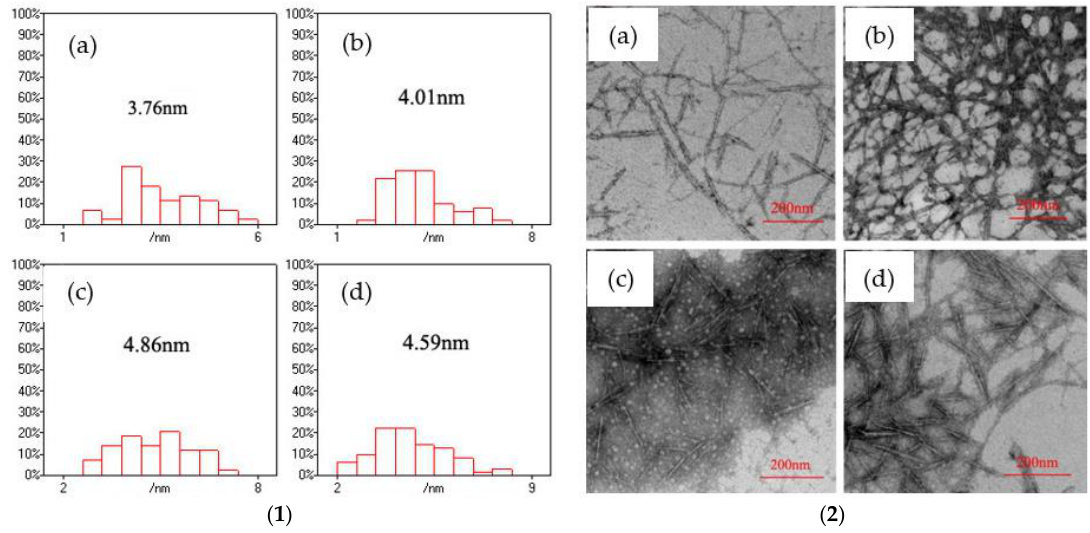
Figure 5. ( 1 ) The size distributions of the CdS nanoparticles with different Na 2 S feeding time; and ( 2 ) the TEM images of CNF/CdS nanocomposites with different Na 2 S feeding time; ( a ) 10 min; ( b ) 20 min; ( c ) 30 min; and ( d ) 40 min (–COOH/Cd 2+ ratio 2.0, ultrasonic maturing time 60 min).